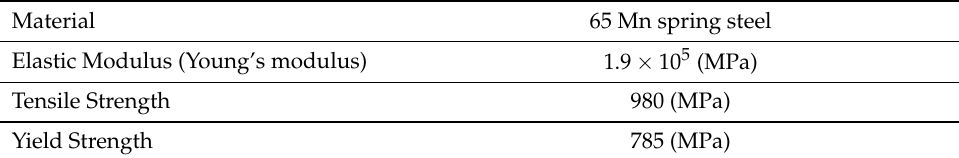
Table 2. Material properties.